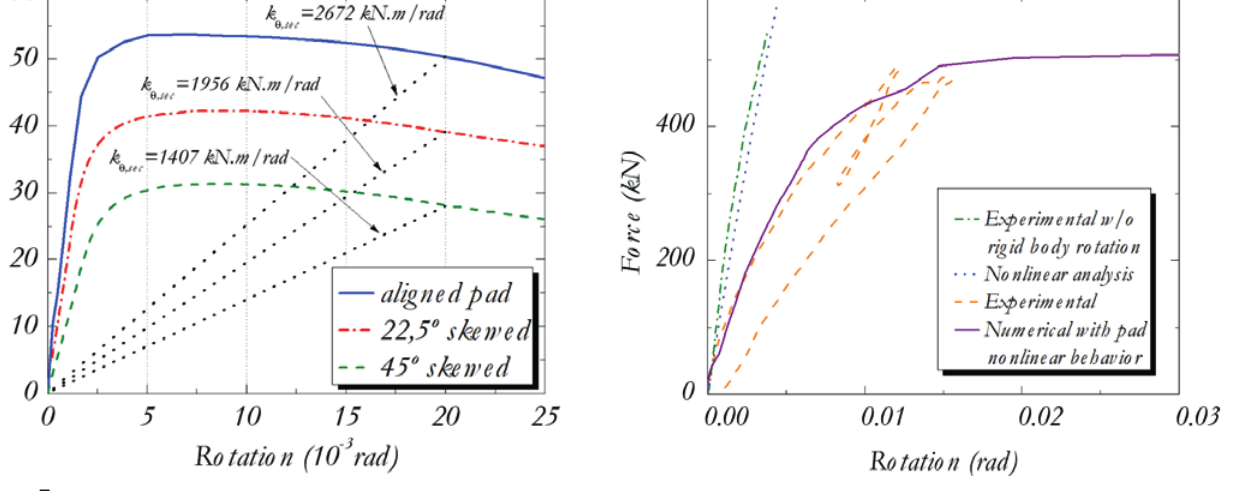
count for initial lateral imperfection.